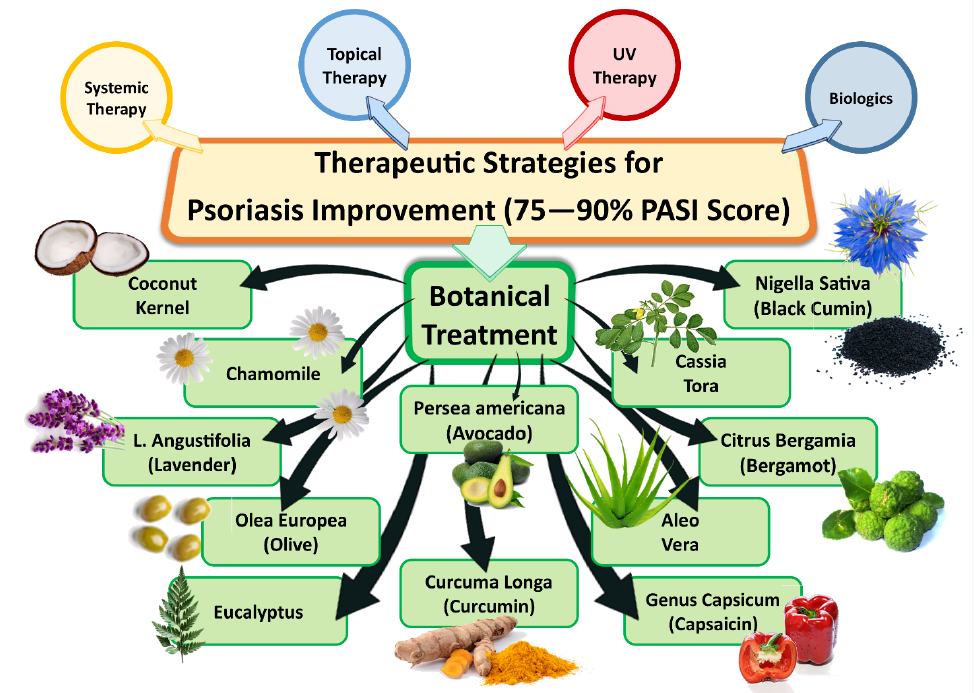
Figure 2. Different therapeutic approaches for alleviation of psoriasis.